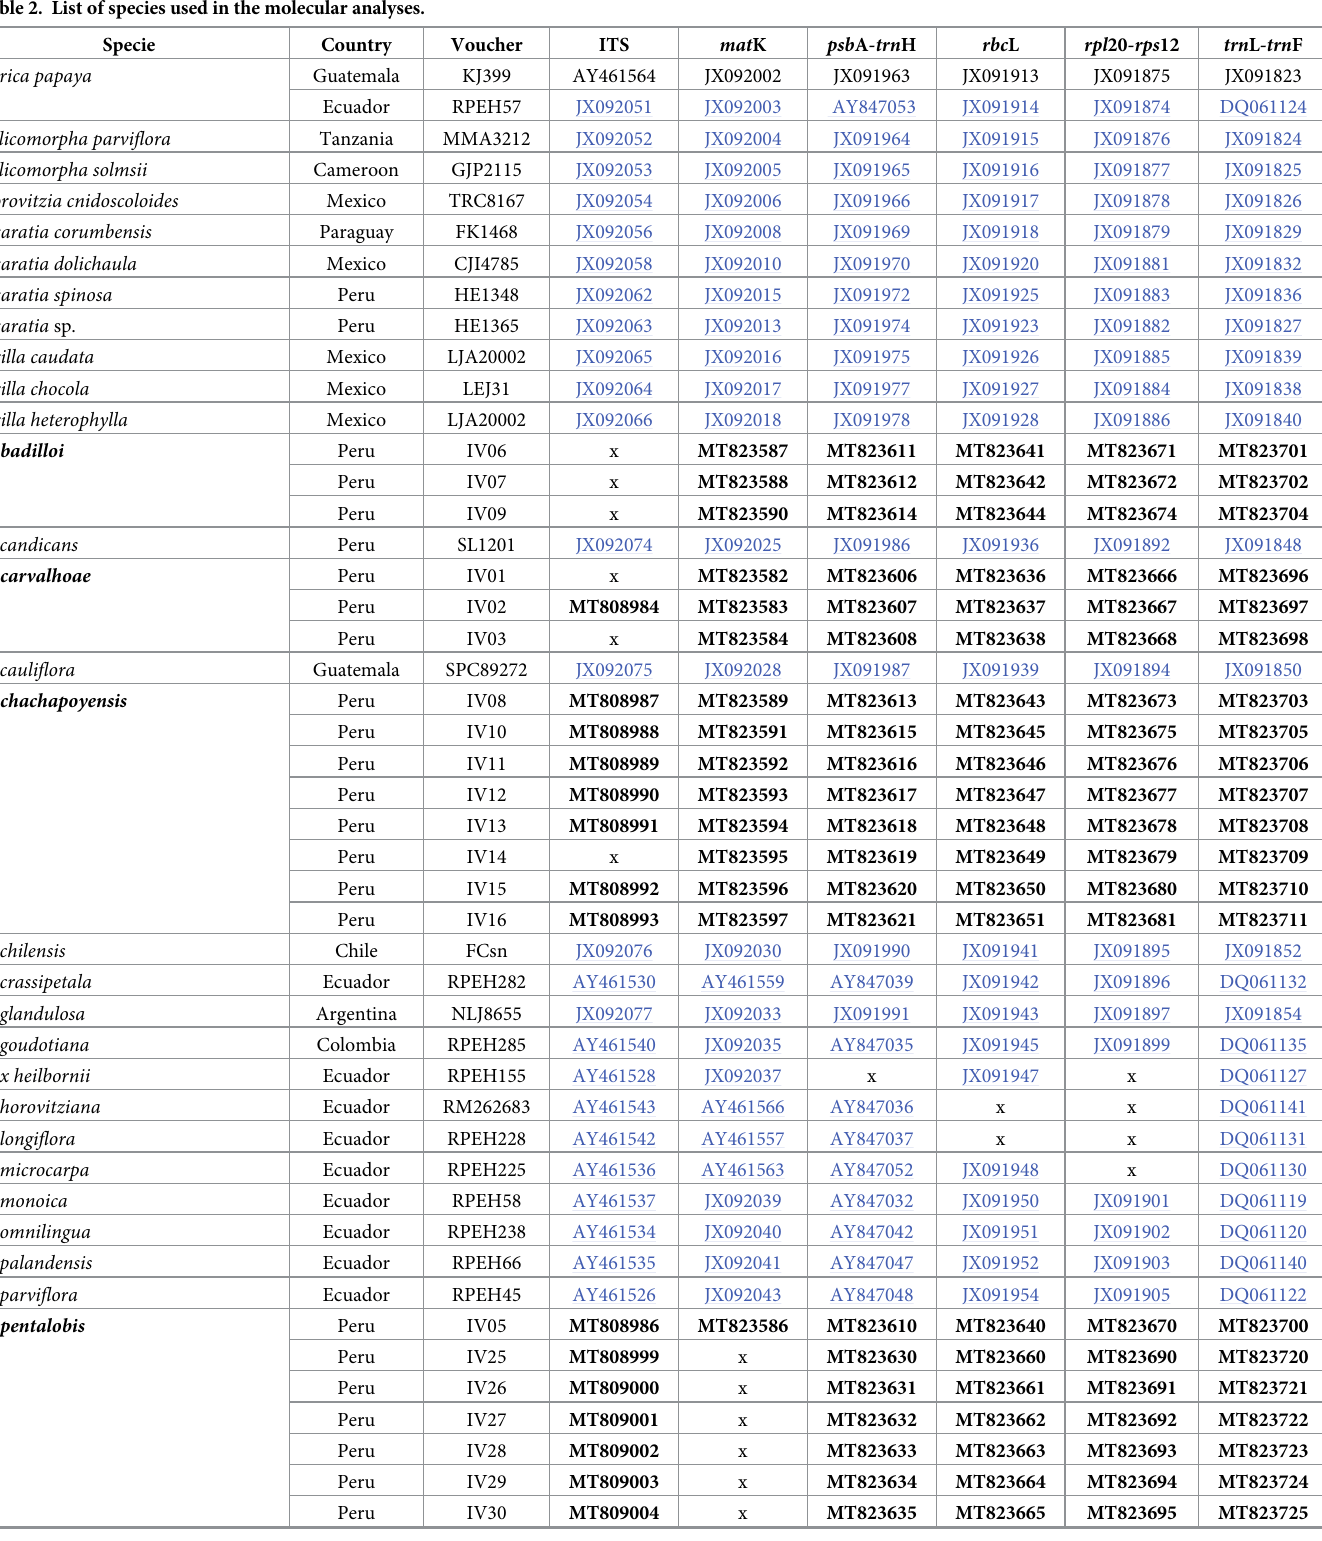
Table 2. List of species used in the molecular